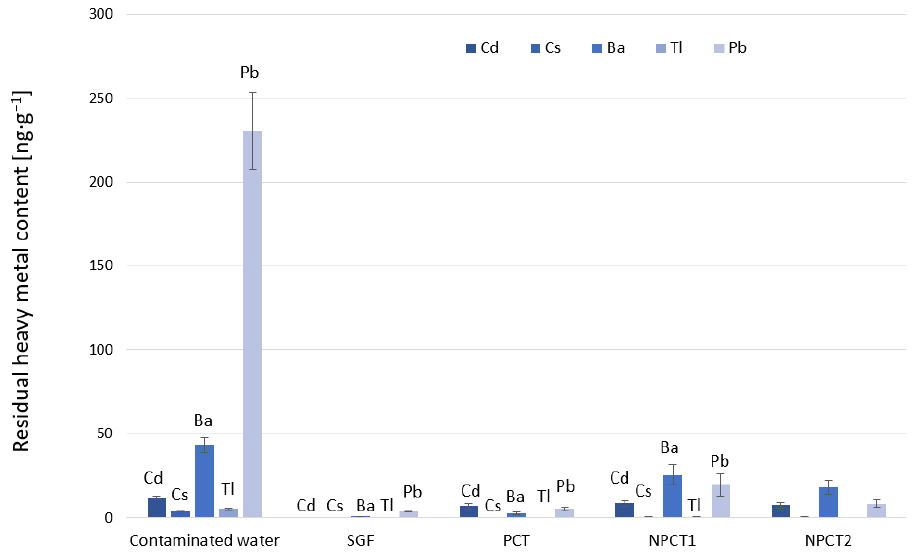
Figure 3. Adsorption of heavy metal ions from SGF onto PCT and NPCTs after 20 min contact time. The figure is based on data from Tables S5–S7 in the Supplementary